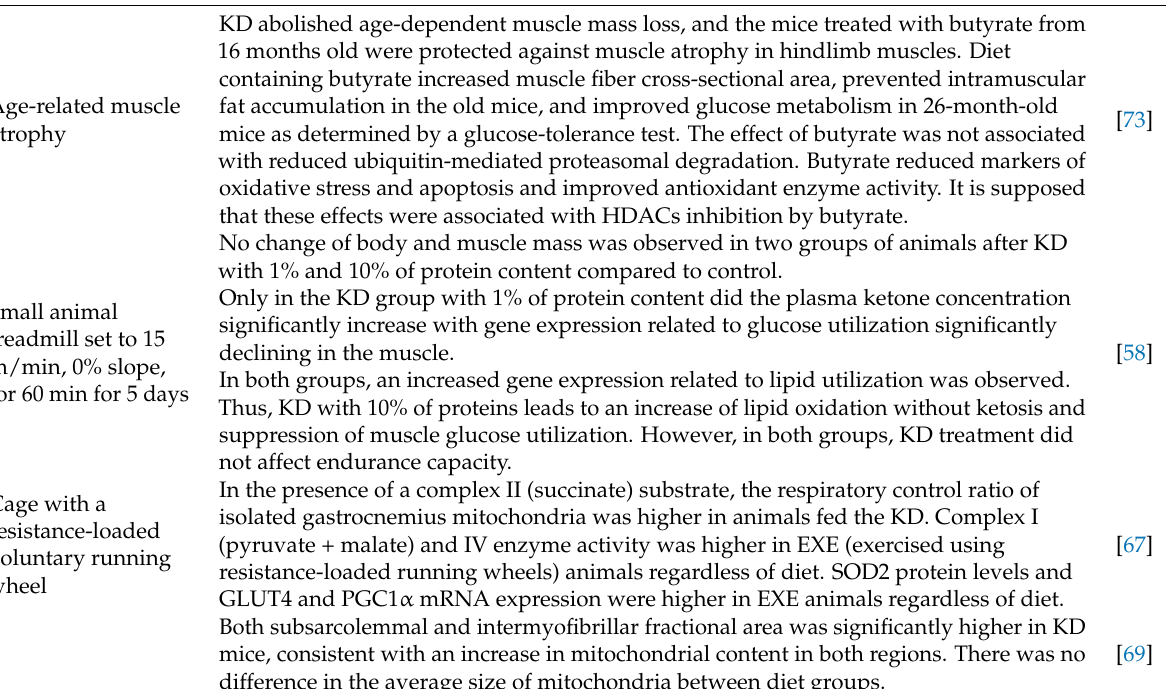
Cage with a resistance-loaded voluntary running